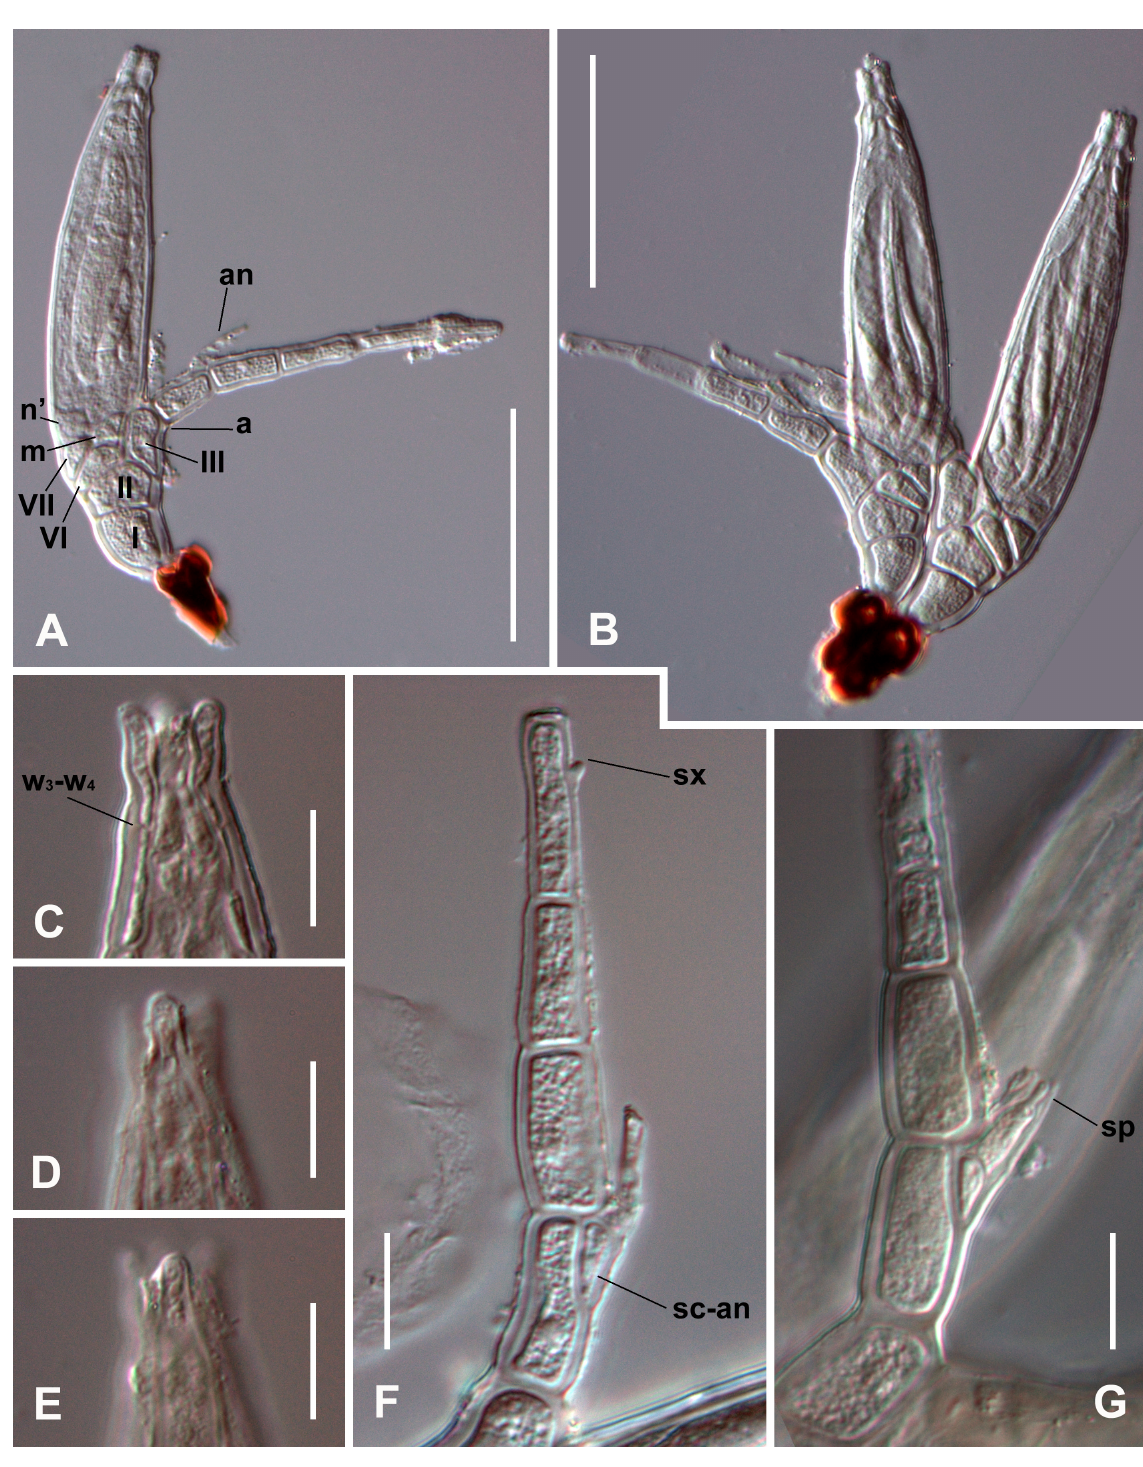
Fig. 1. Diplopodomyces coronatus Santam., Enghoff & Reboleira sp. nov. A . Mature thallus with labelling of cells and other elements. B . Paired mature thalli. C – E . Perithecial apex at three different focusing levels to highlight the four blunt lips and the bulging at w appendage. Scale bars: 50 µm (A–B) and 10 µm (C–G). Photographs from: slides SS E585a (A–E) and C-F-92266